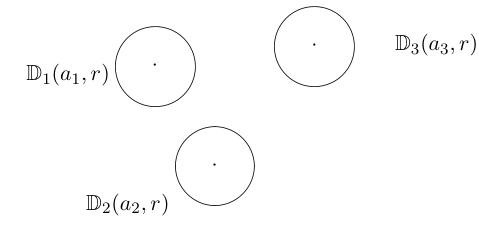
Figure 3. Symmetries with respect to three